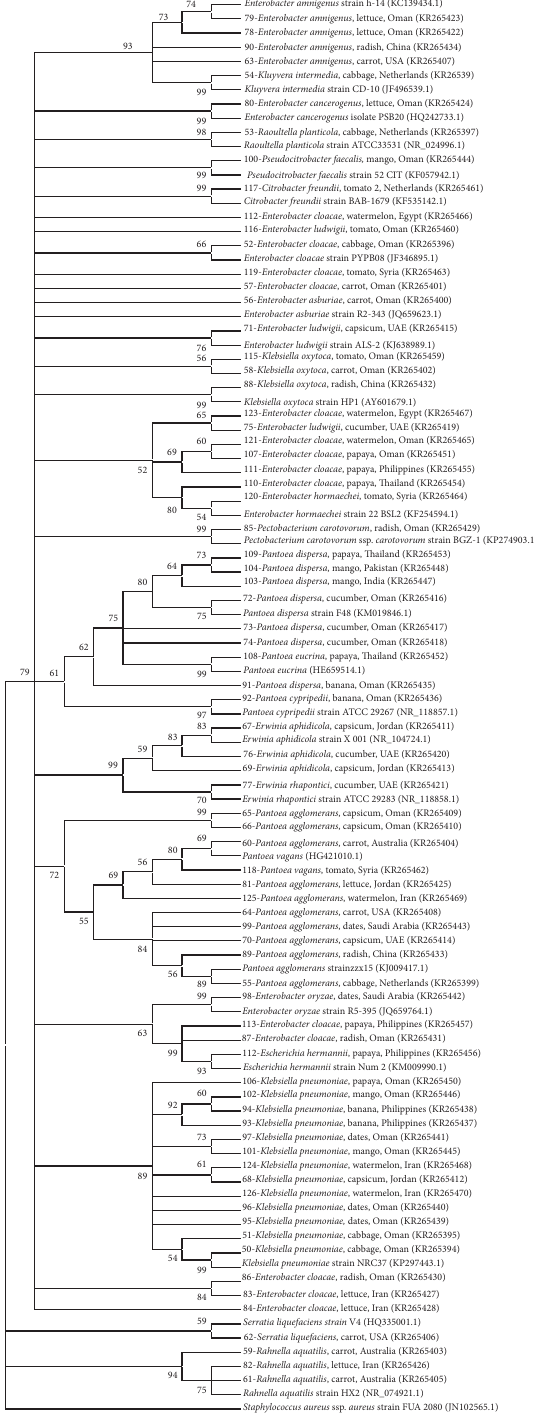
Figure 2: Neighbor joining tree based on 16S rRNA gene sequences of members of Enterobacteriaceae isolated from fresh produce. Staphylococcus aureus (JN102565) was included as an outgroup. KR-accession numbers correspond to gene sequences that belong to isolates analyzed in this study while others were obtained from NCBI database. Bootstrap values above 50% are shown (1000